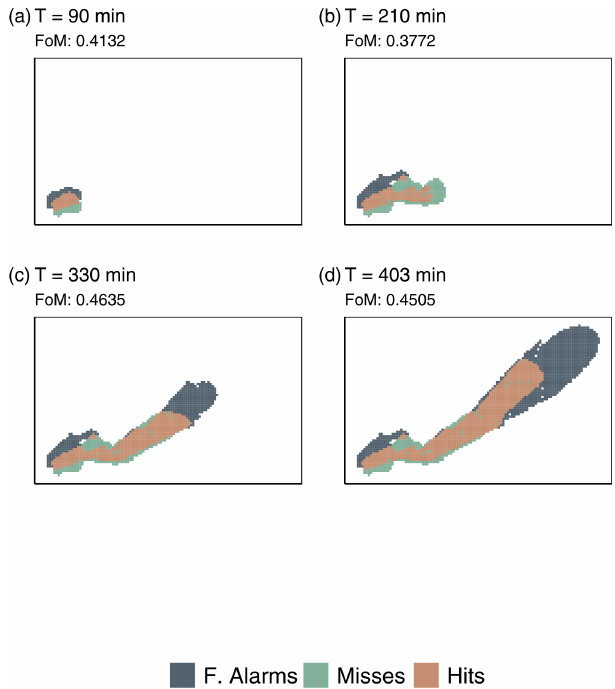
Figure 8. Components of FoM for case 3 at four times past